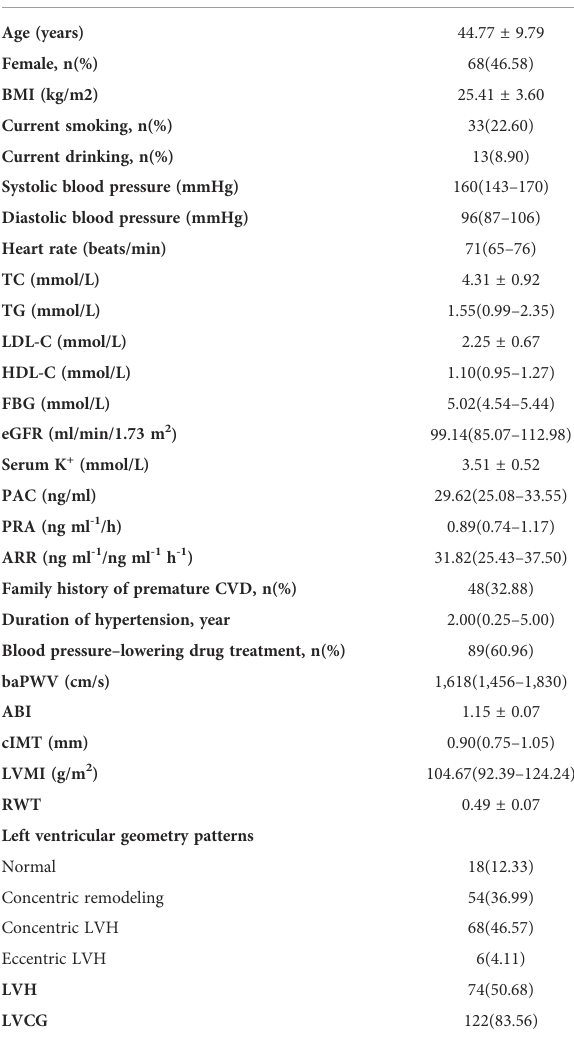
TABLE 1 Characteristics of study